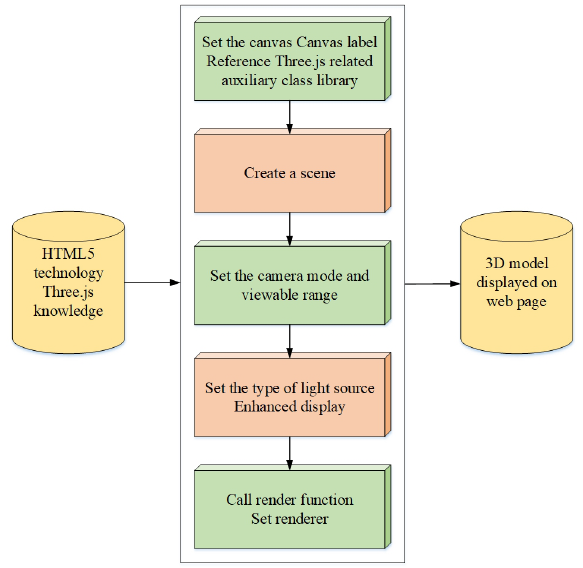
Fig. 7. The development process of